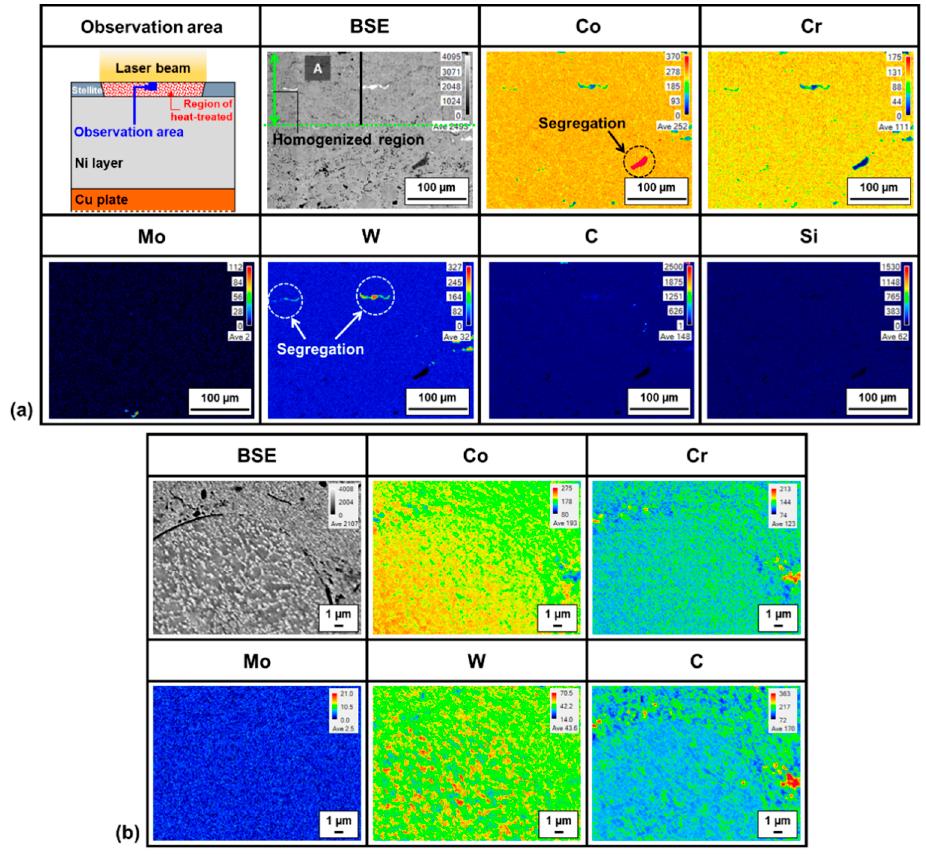
Figure 9. ( a ) Element distribution and ( b ) BSE images of Stellite-1 coating after laser heat treatment at 1373 K.